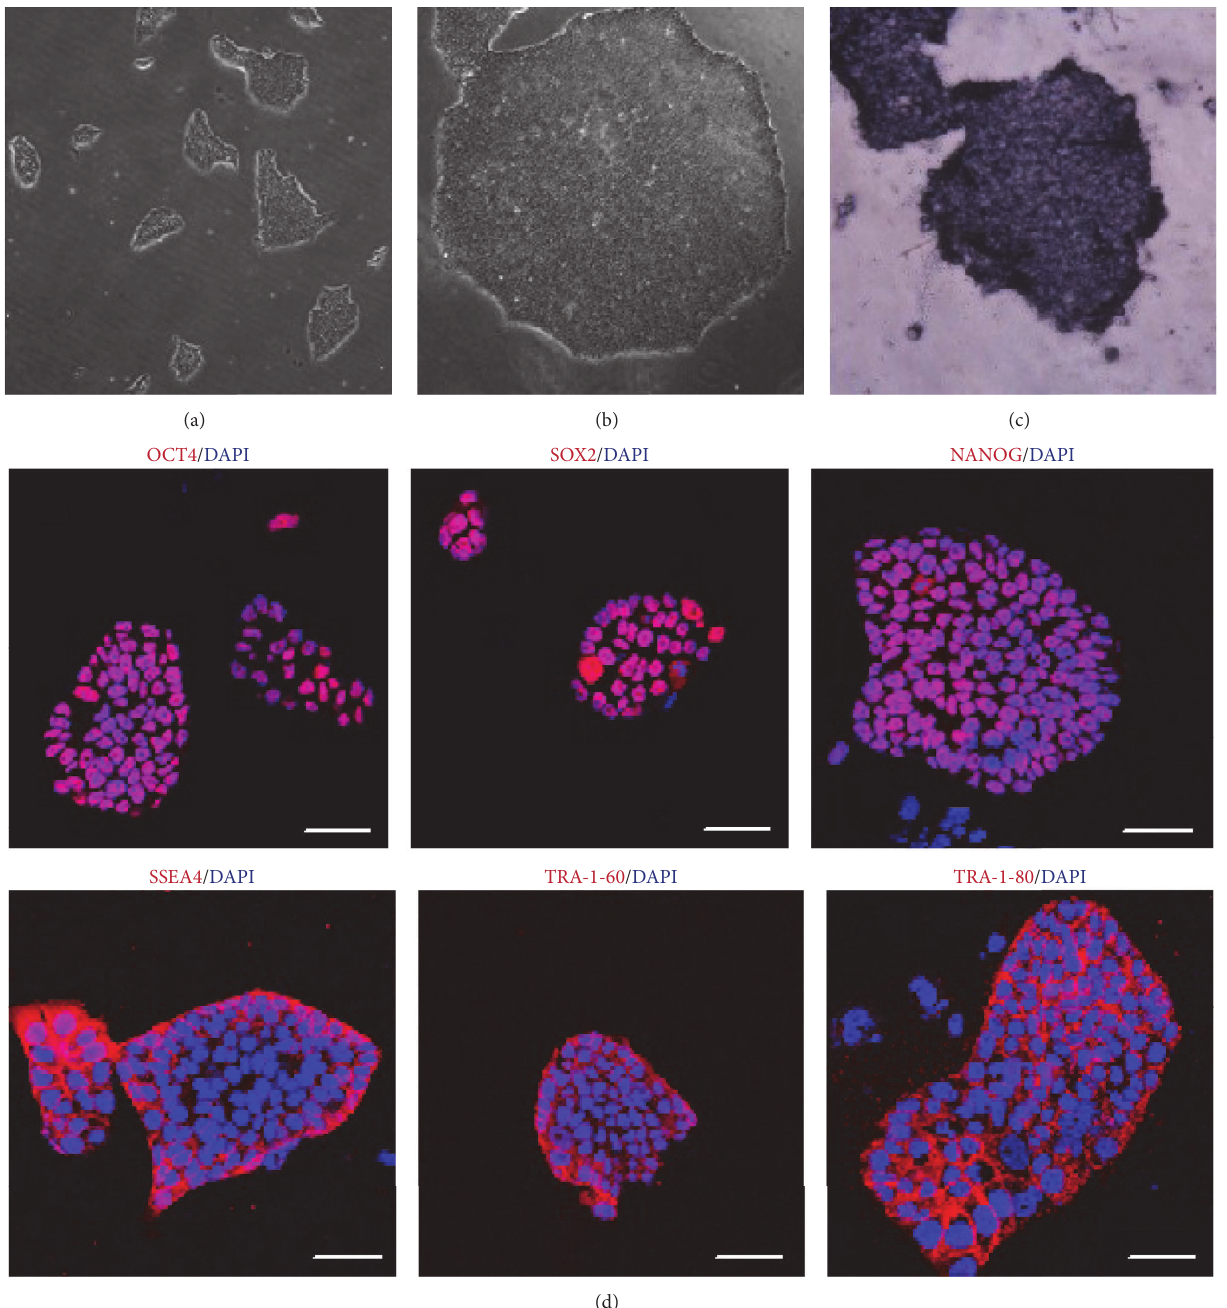
Figure 2: Morphology of NiPS colonies by 1F-OCT4. Low (a) and high (b) magnification of NiPS colonies. 1F-OCT4 human NiPS colonies were stained for alkaline phosphatase (c); immunofluorescent analysis of pluripotency and surface markers (d). The pluripotent markers (OCT4, SOX2, and NANOG) and surface markers (SSEA4, TRA-1-60, and TRA-1-81) were stained with antibodies in human 1F-OCT4 NiPS cells. Nuclei are stained with DAPI (blue). Scale bars, 100 𝜇